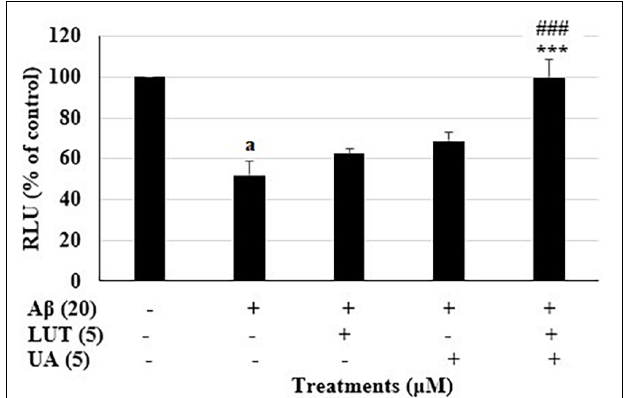
FIGURE 3 | Relative ATP levels for the combination 11 (L 5 U 5 ) and its components. ATP levels for the combination 11 (L 5 U 5 ) and its constituents were determined using CellTiter Glo assay. Data are expressed as mean ± SD from four ( N = 4) independent experiments. Differences are significant